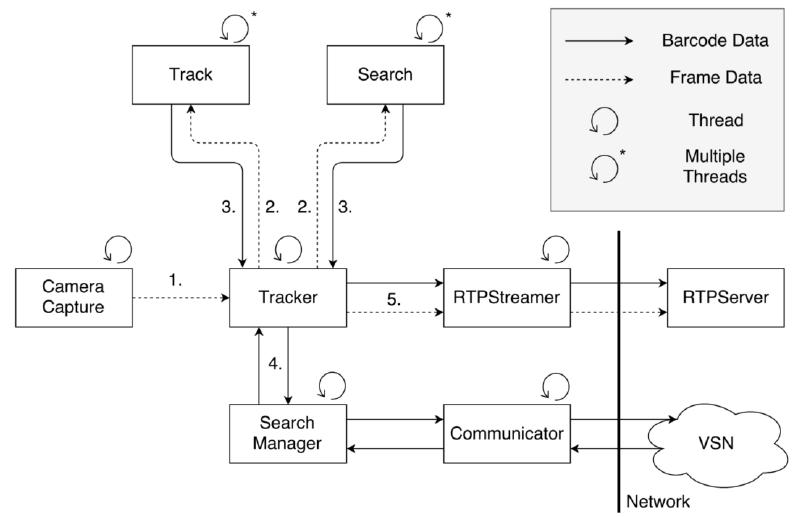
Figure 9. Workflow of barcode tracking